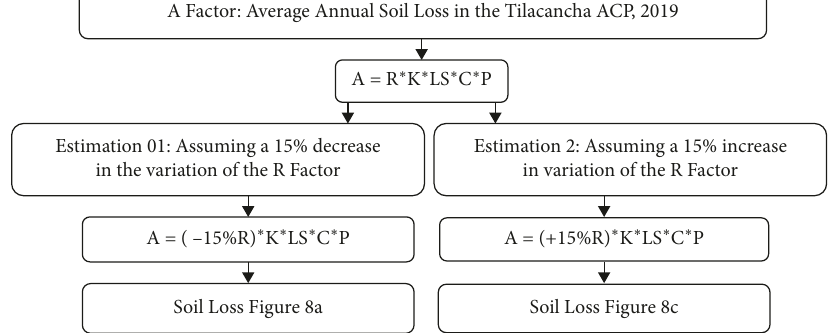
15% of annual pp, (b) current −